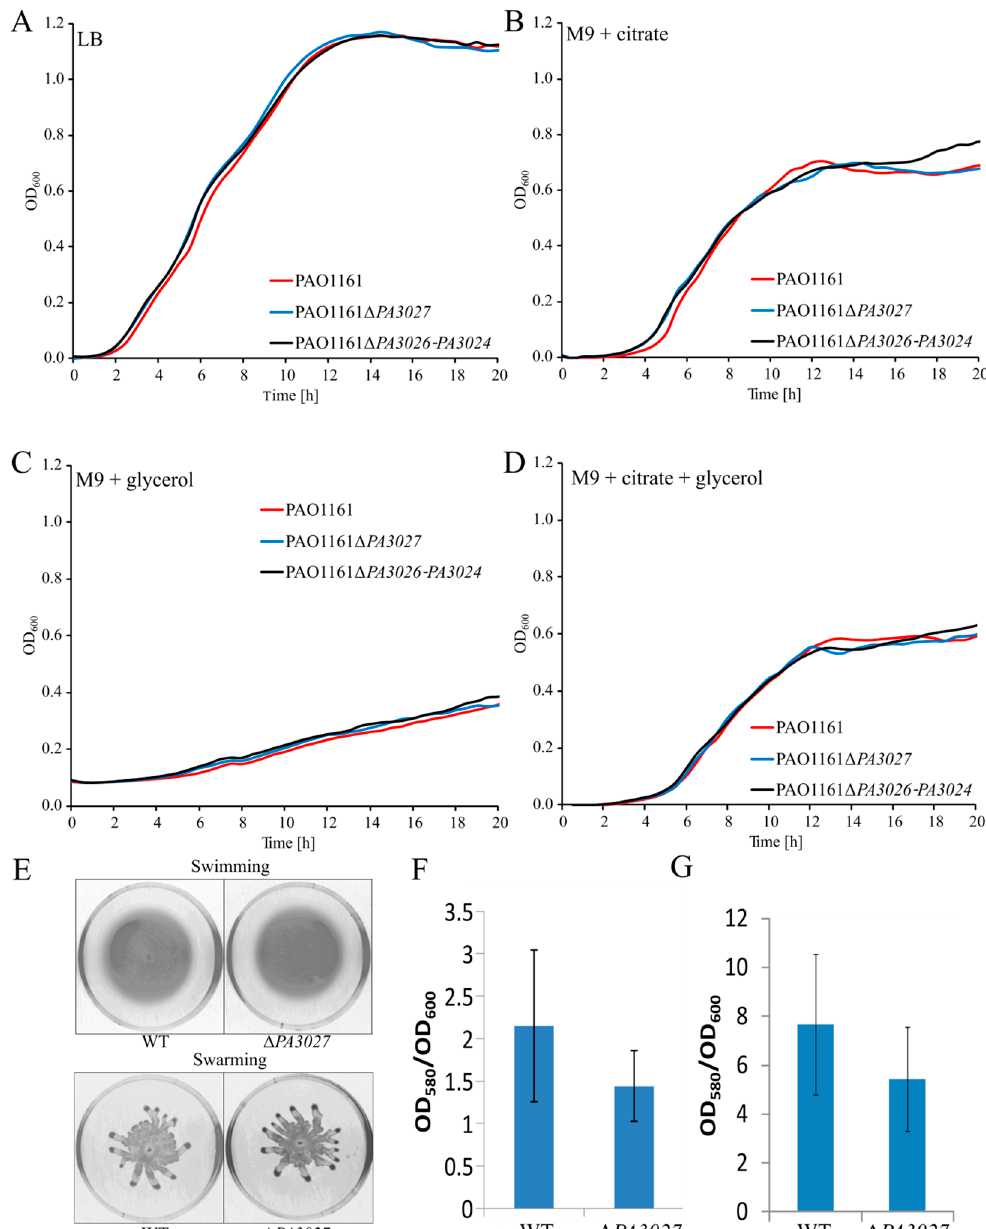
Figure A1. Impact of PA3027 excess on the growth of P. aeruginosa PAO1161. PAO1161 or Δ PA3027 mutant strains carrying empty vector pAMB9.37 tac p or pKKB1.11- tac p- PA3027 ( A , B ) or empty vector tac p– flag or pKKB1.12 tac p– flag – PA3027 ( C , D ) were grown in L-broth under selection with the indicated concentration of inducer IPTG (0.05–0.5 mM). The red line indicates the growth in the presence of 0.05 mM IPTG, conditions selected for RNA-seq analysis. Data represent mean OD 600 from three independent replicates. Standard deviations are not shown for clarity.